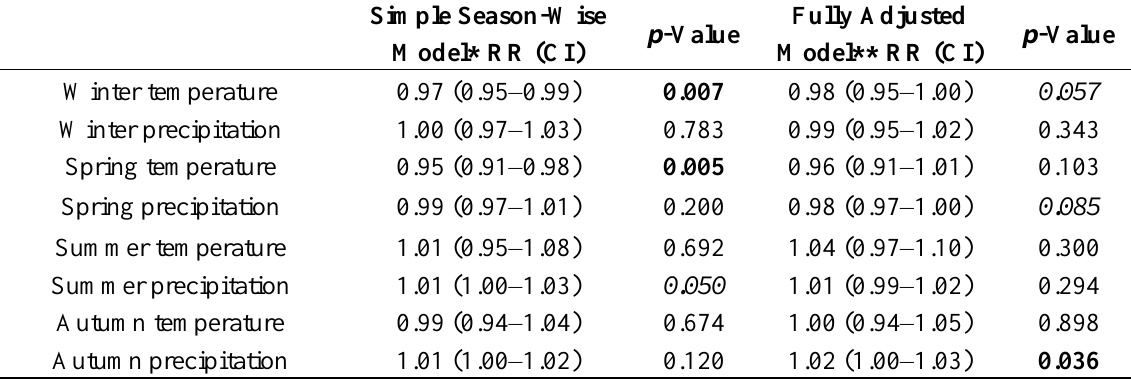
Table 1. Association between seasonal climate variability and annual mortality, Skellefteå